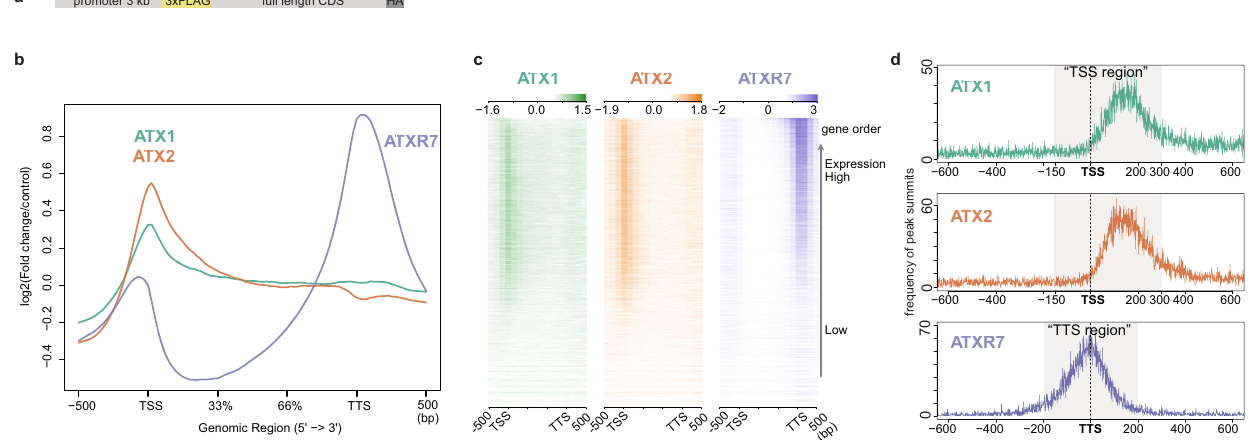
Fig. 2 | ATX1 and ATX2 occupy TSS while ATXR7 occupies TTS. a The transgene structure of tagged ATX(R) proteins used for ChIP-seq. b , c Metaplot ( b ) and heat maps ( c ) illustrating ATX1, ATX2, and ATXR7 distributions inthe gene body region corrected with a non-transgenic control. The heat map was sorted so that highly transcribed genes (measured as mRNA-seq in WT) come to the top. d Position of ATX1andATX2ChIP-seqpeaksummitsrelativetoTSSandATXR7peaksrelativeto